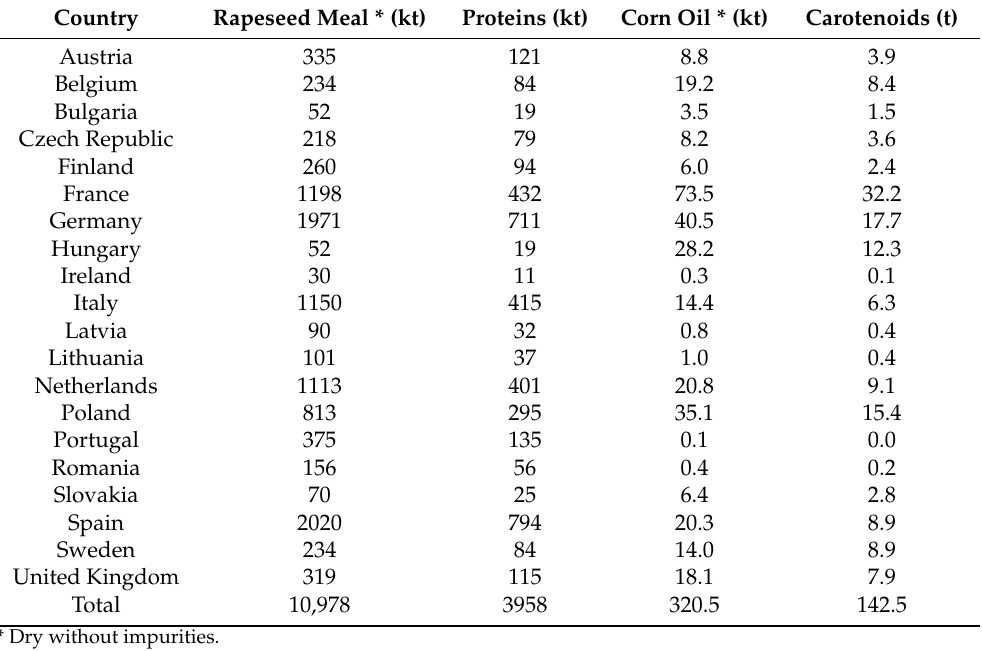
Table 4. Estimated corn oil and rapeseed meal generated in Europe in 2020 and potential production of proteins from rapeseed meal and carotenoids from corn oil in European countries. Country Rapeseed Meal * (kt)